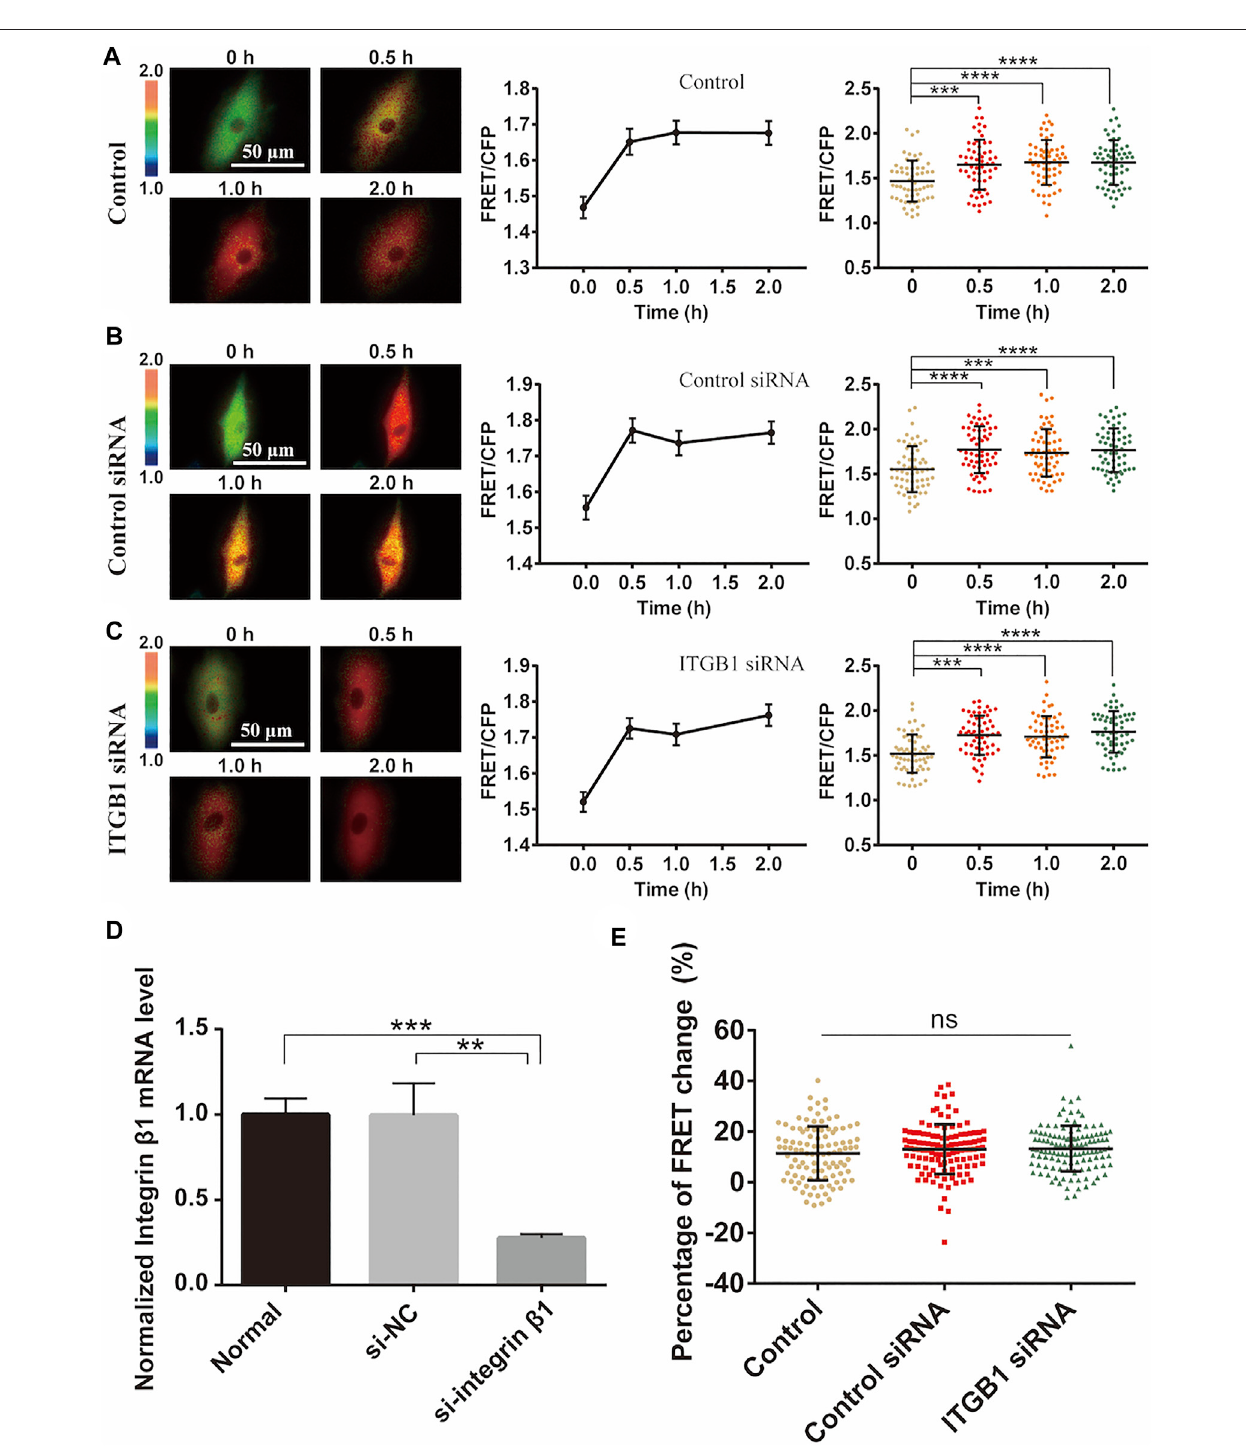
FIGURE 6 | Integrin β 1 (ITGB1) signal in cyclic stretch-induced ERK activation. ASM cells were transfected with ITGB1 inhibitory siRNA, followed by cyclic stretch and imaging. (A – C) FRET ratiometric images along with FRET change quanti fi cations are shown before and after cyclic stretch in ASM cells without transfection (A) , or transfected with control scramble siRNA (B) and ITGB1 siRNA (C) ( n = 58, 60, 58), respectively. (D) qPCR quanti fi cation from three experimental data con fi rmed the reduced level of ITGB1 mRNA expression after siRNA transfection. (E) Statistical comparisons of FRET percentage changes in cells without transfection, or transfected with control or ITGB1 siRNA ( n = 103, 116, 121) (E) before and after 0.5 h stretch. Student ’ s t-test was performed between the control and one experimental group.